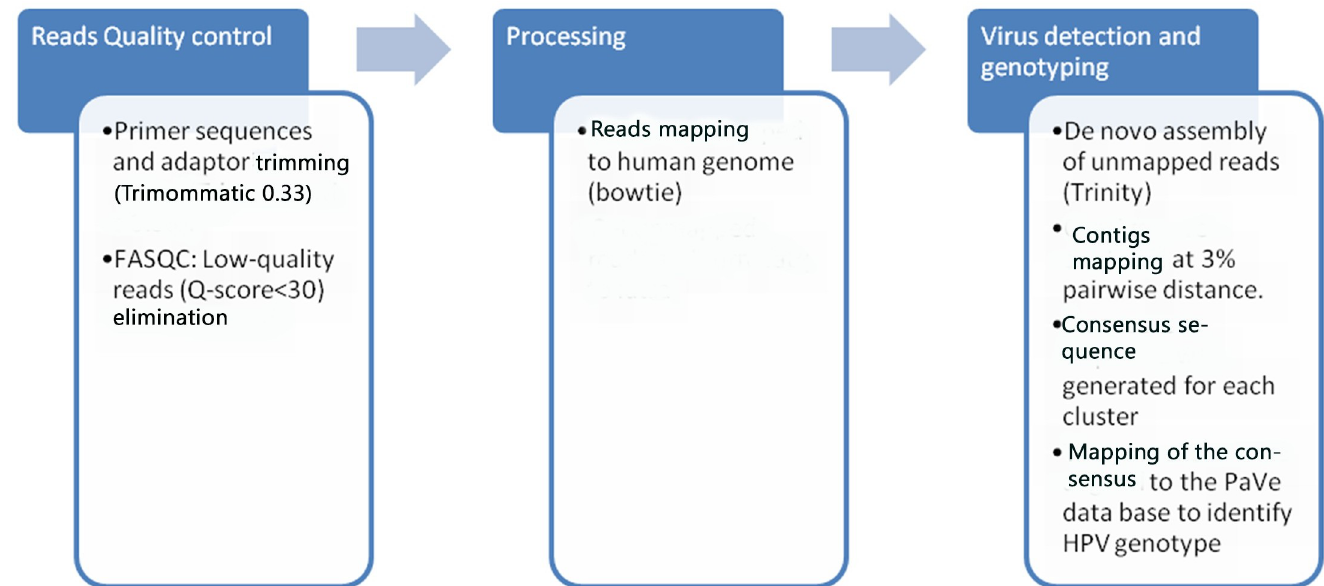
Fig 2. Workflow for data analysis. The designed pipeline for HPV genotyping in this study contains 3 steps: reads quality control to remove bad quality reads, processing of retained reads for mapping into Human genome, and finally in the final set of selected sequences the viruses were detected and genotyped by assembly and contigs mapping to HPV reference